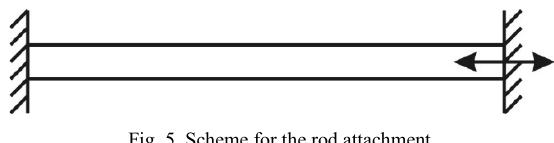
Fig. 5. Scheme for the rod attachment.